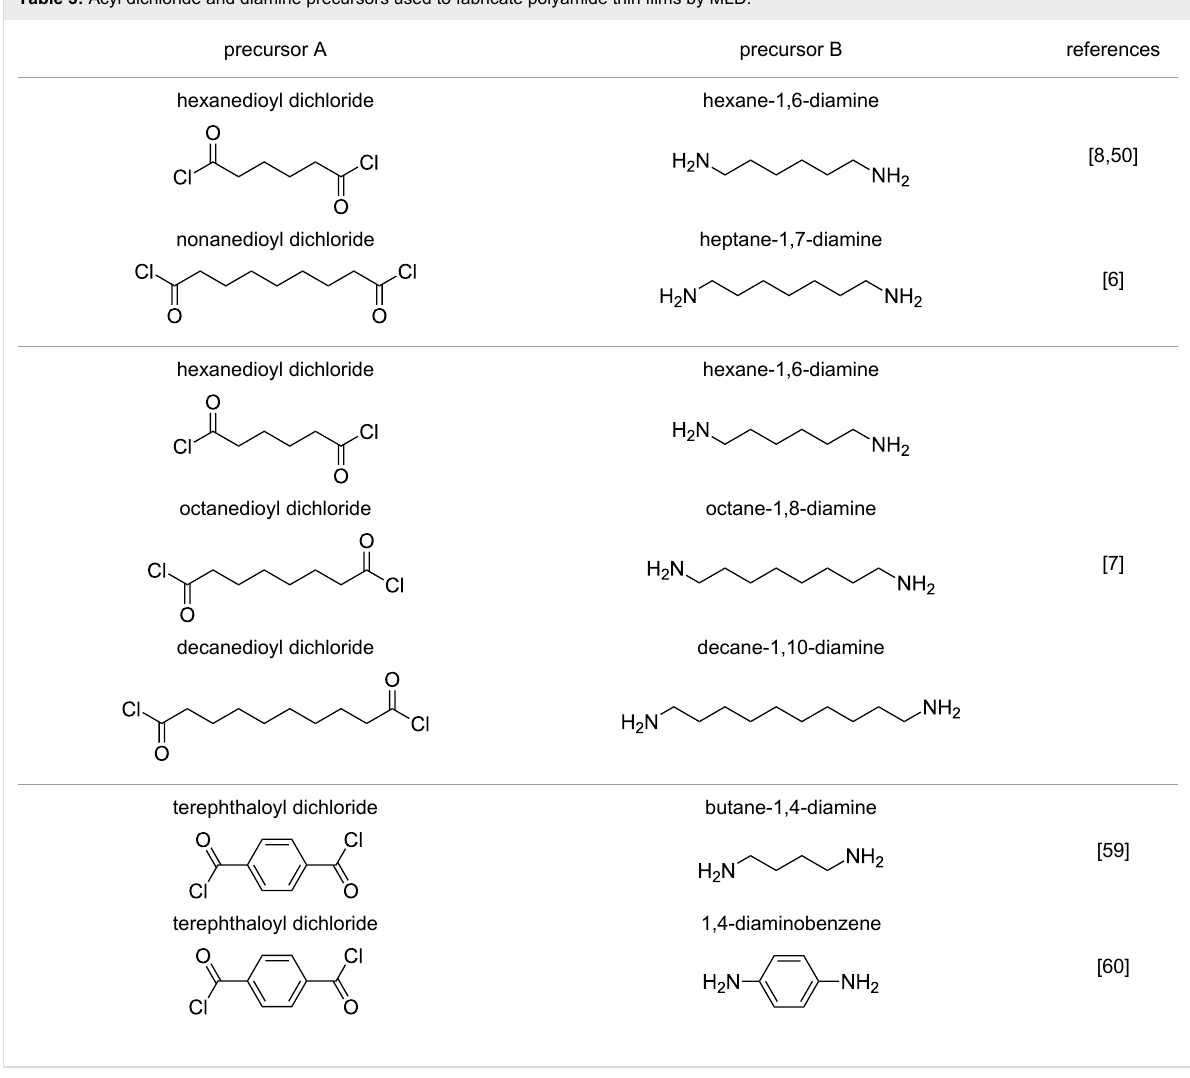
Table 3: Acyl dichloride and diamine precursors used to fabricate polyamide thin films by